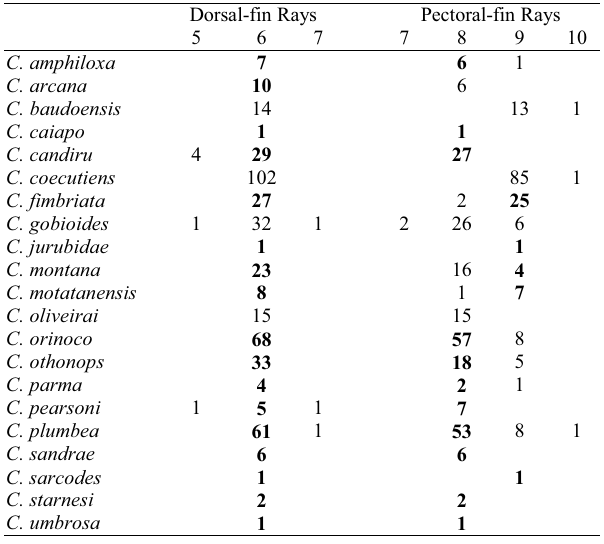
Table 9. Number of specimens of the species of Cetopsis with cited number of dorsal- and pectoral-fin rays. Bold indicates value for holotype or lectotype when examined. Dorsal fin of C. jurubidae damaged and count of rays uncertain; 6 branched dorsal-fin rays cited for holotype of species by Fowler (1944:235).